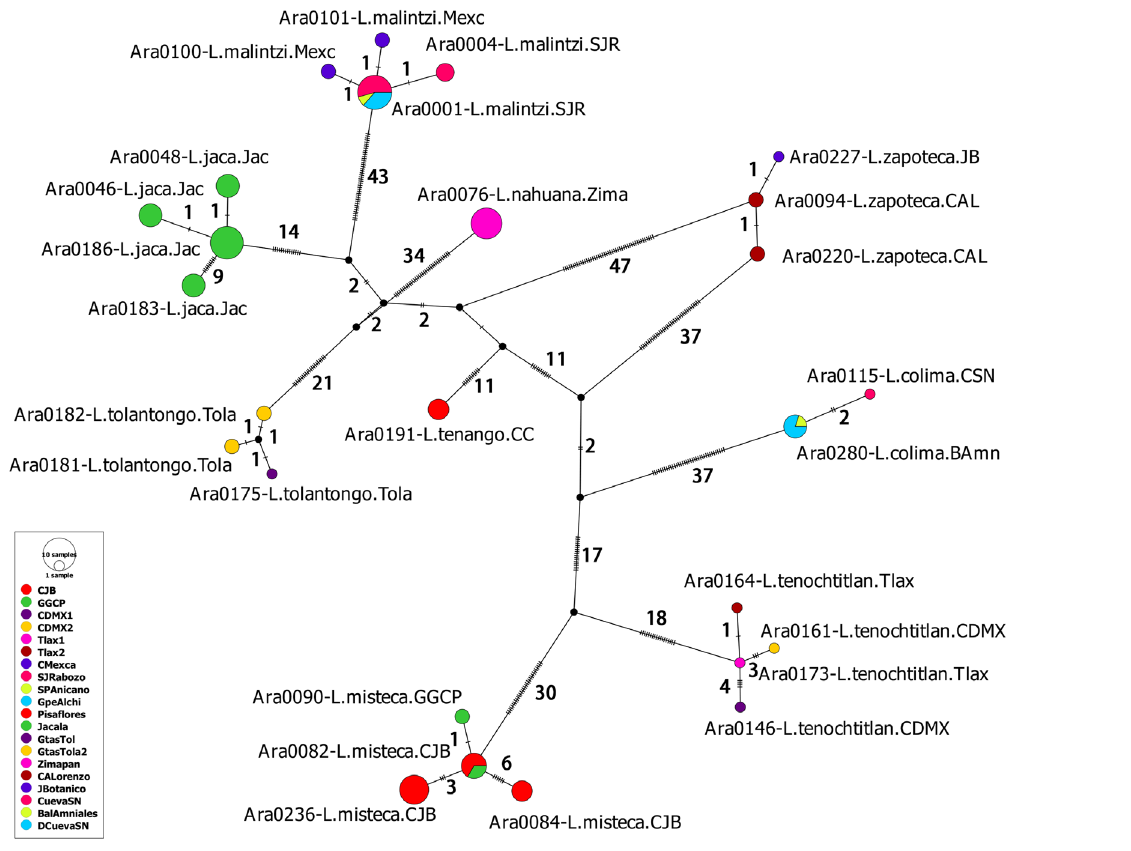
Fig. 57. Haplotype network from the CO1 data obtained with TCS using PopArt. Each circle represents the haplotypes found in nine species of Loxosceles Heineken & Lowe, 1832 from Mexico. Numbers on branches indicate the number of mutations between